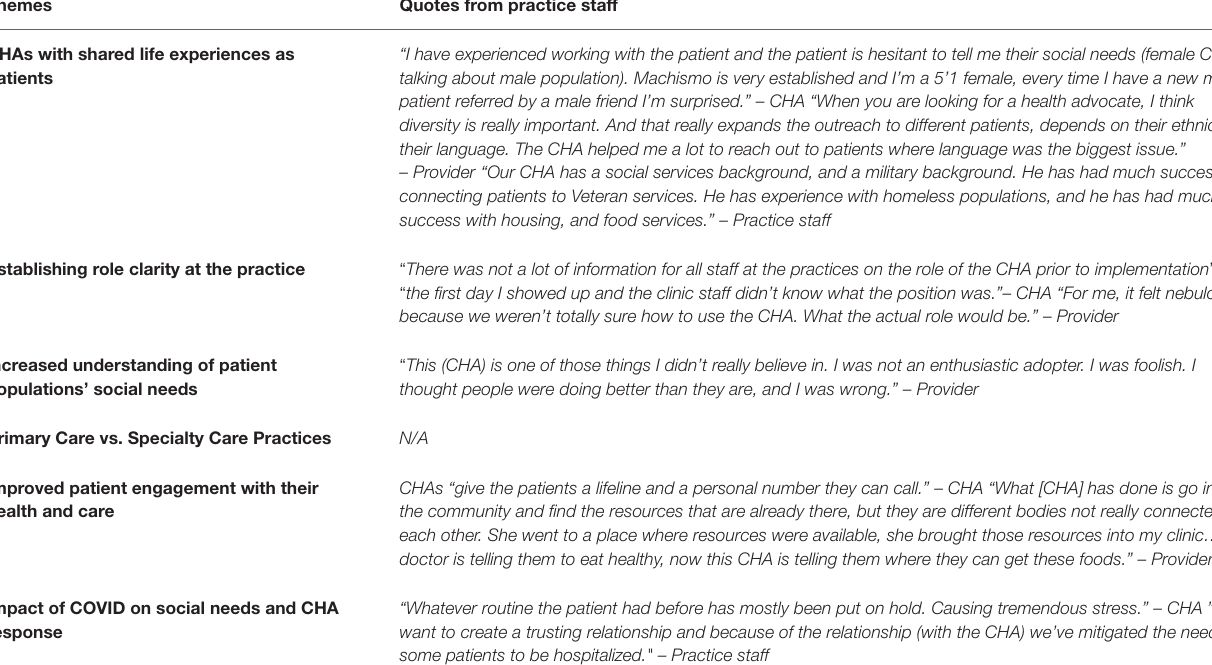
TABLE 3 | There were six key themes from provider, staff, and CHA interviews and focus groups on the perspectives of the CHA role, and what factors enabled his or her success. Themes Quotes from practice staff CHAs with shared life experiences as patients